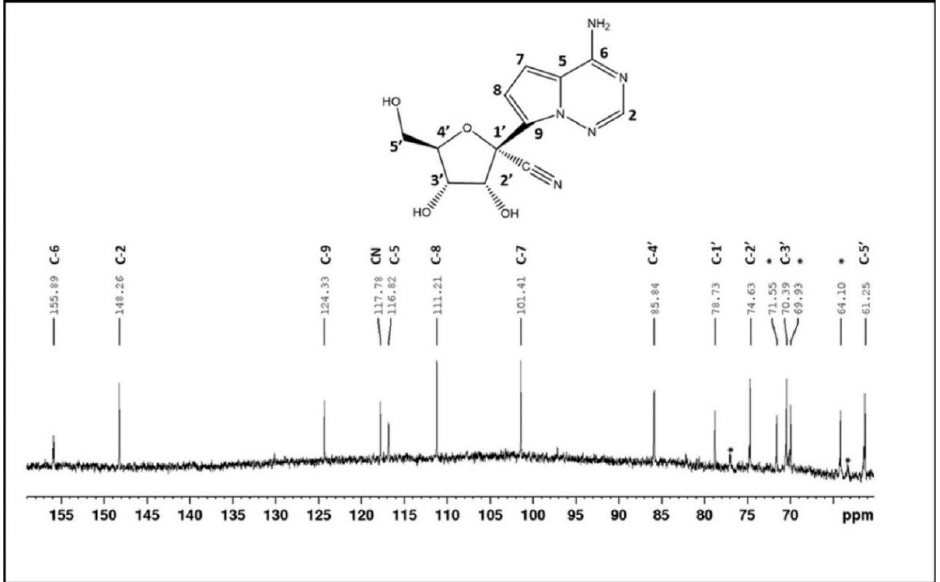
Figure 8. 13C spectrum of the analyzed sample. Labels refer to the assignment of carbons in the active component of Xraphconn ® depicted above. All signals above 100 ppm belong to the cyano-group and nucleobase in the identified compound. Some additional signals of uncharacterized impurities were observed below 80 ppm (indicated with *). Ppm, parts per million